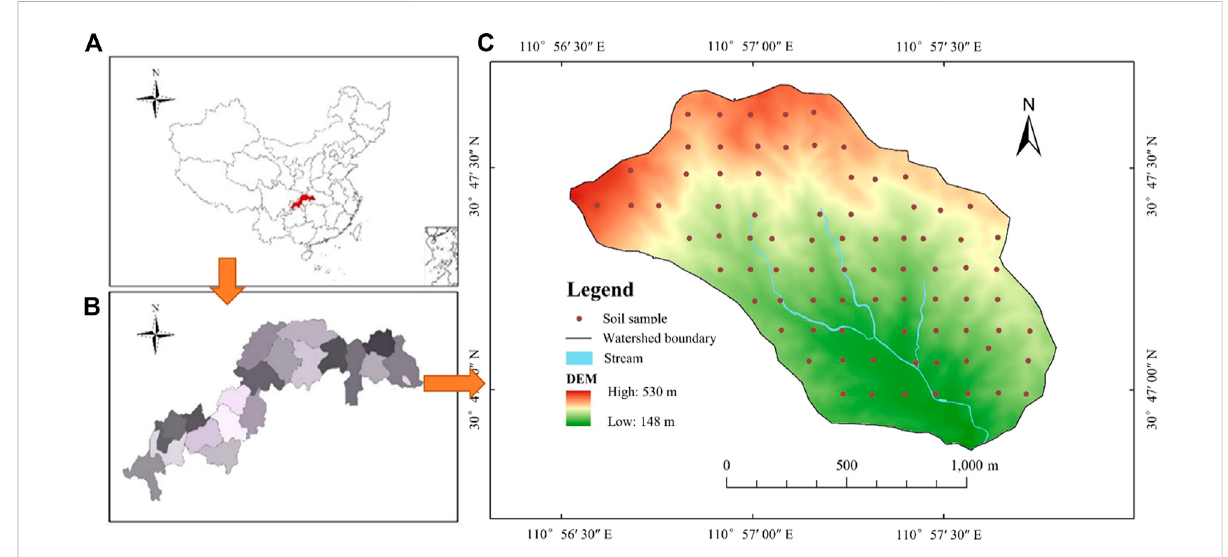
FIGURE 1 Thelocationofthestudy sites (A) :ThreeGorgesReservoirAreainChina; (B) ZhangjiachongWatershedintheThreeGorgesReservoirArea)and (C) the digital elevation model (DEM), drainage system of Zhangjiachong Watershed, China. The red dot represents the sampling